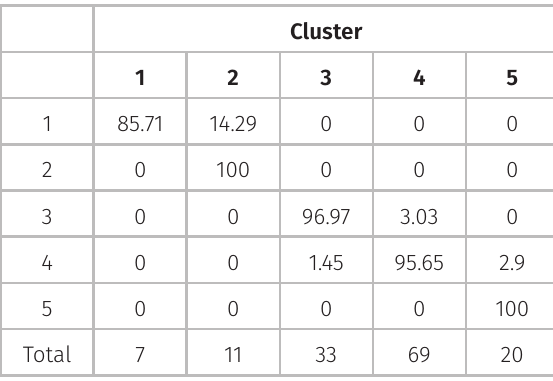
Table IV. Percentage of correct designation of Higher Education Institutions to clusters .